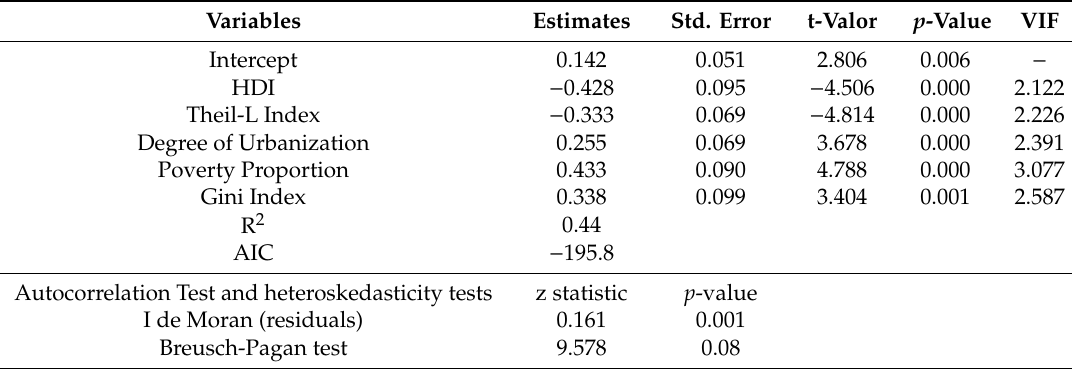
Table 2. Results of the OLS model for homicide